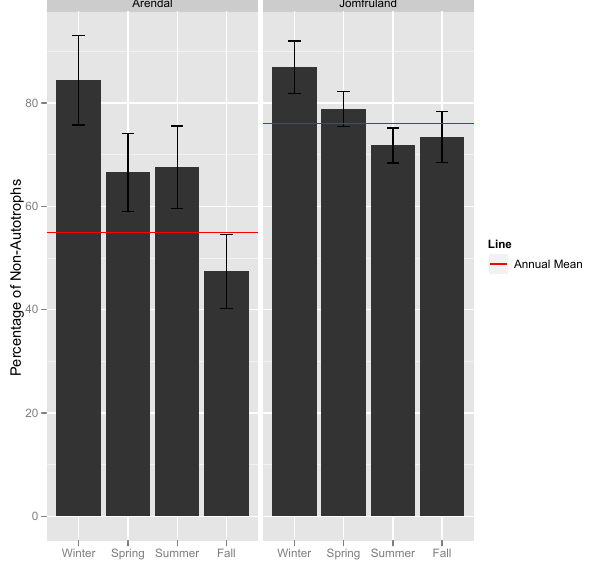
Fig. 9. Calculated non-autotrophic percentage of total seston from regression model for Arendal and Jomfruland, with annual mean percentage and error bars showing the SE.